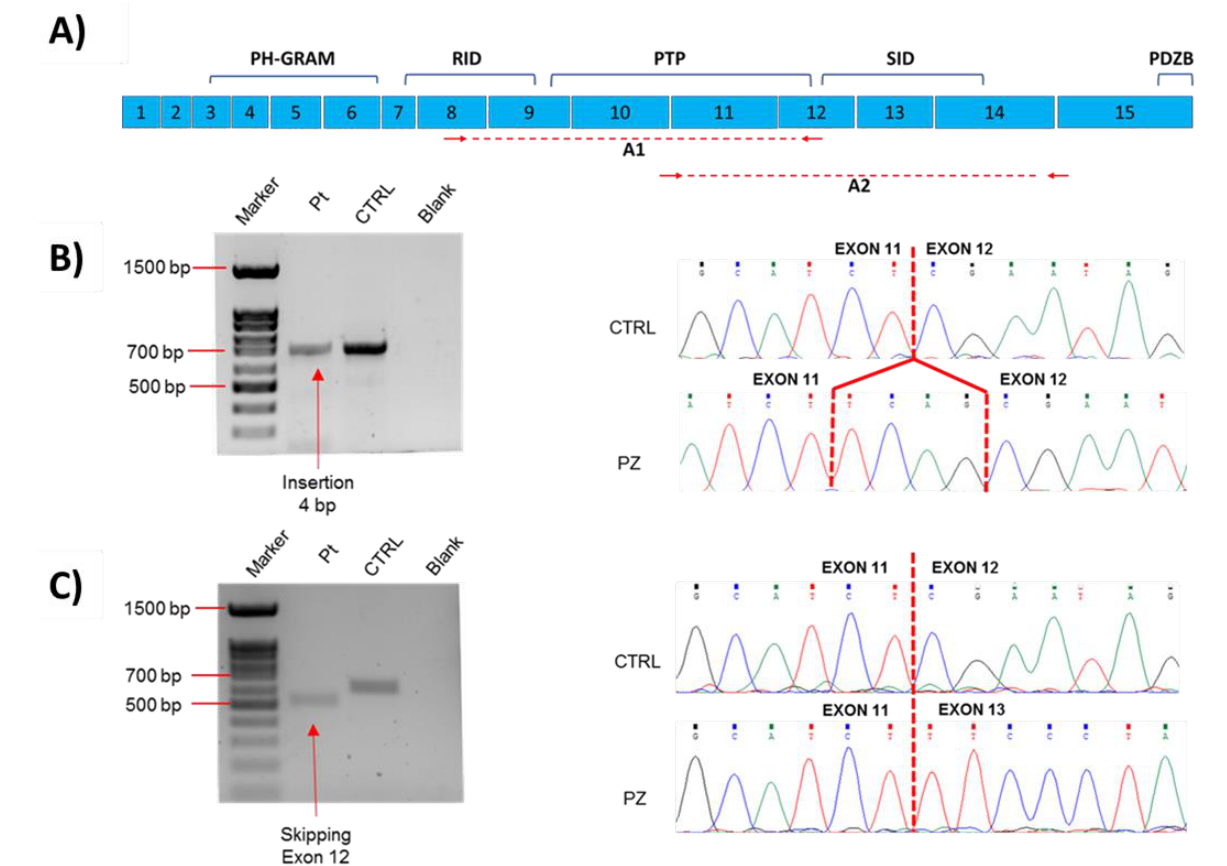
Figure 3. Genetic analyses of aberrant splicing mechanism caused by the novel MTM1 splicing variant. ( A ) Schematic representation of MTM1 mRNA showing different protein domains; amplicons (A1 and A2) used for detecting aberrant transcripts are underlined with red dashed line, and primers used for generating these different amplicons are represented with red arrows. ( B , C ) Agarose gel electrophoresis and Sanger sequencing of cDNA from muscle showing aberrant transcripts in patient compared to control. ( B ) Amplicon A1 (encompassing exon 8 to 12). It is not possible to appreciate the insertion of 4 bp because amplicon size in the patient ( ≈ 702 bp) is similar to the control’s one ( ≈ 698 bp). ( C ) Amplicon A2 (encompassing exon 11 to 14). Amplicon size in the patient is lower ( ≈ 498 bp) than in the control ( ≈ 591 bp) because of the skipping of exon 12. Gel electrophoresis run of Amplicon A2 did not show both aberrant transcripts simultaneously, probably because the transcript with exon 12 skipping is much more abundant than the transcript with inclusion of 4 nucleotides, which, for this reason, is detected only using specific primers. Lane 1: 100 bp DNA ladder marker; Lane 2: Patient; Lane 3: Control; Lane 4: